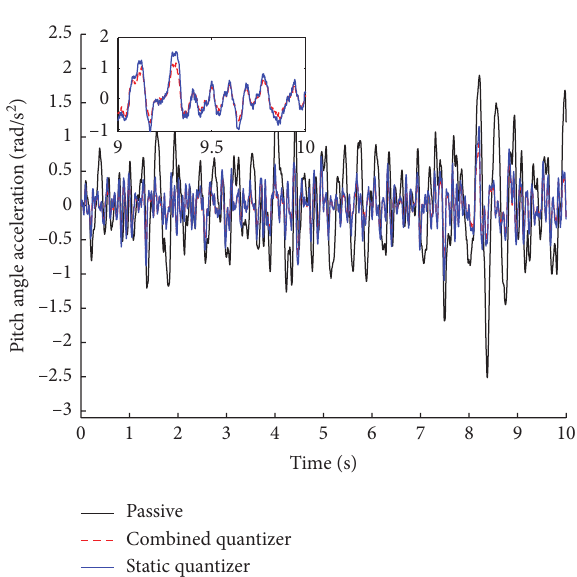
Figure 6: Sprung mass pitch